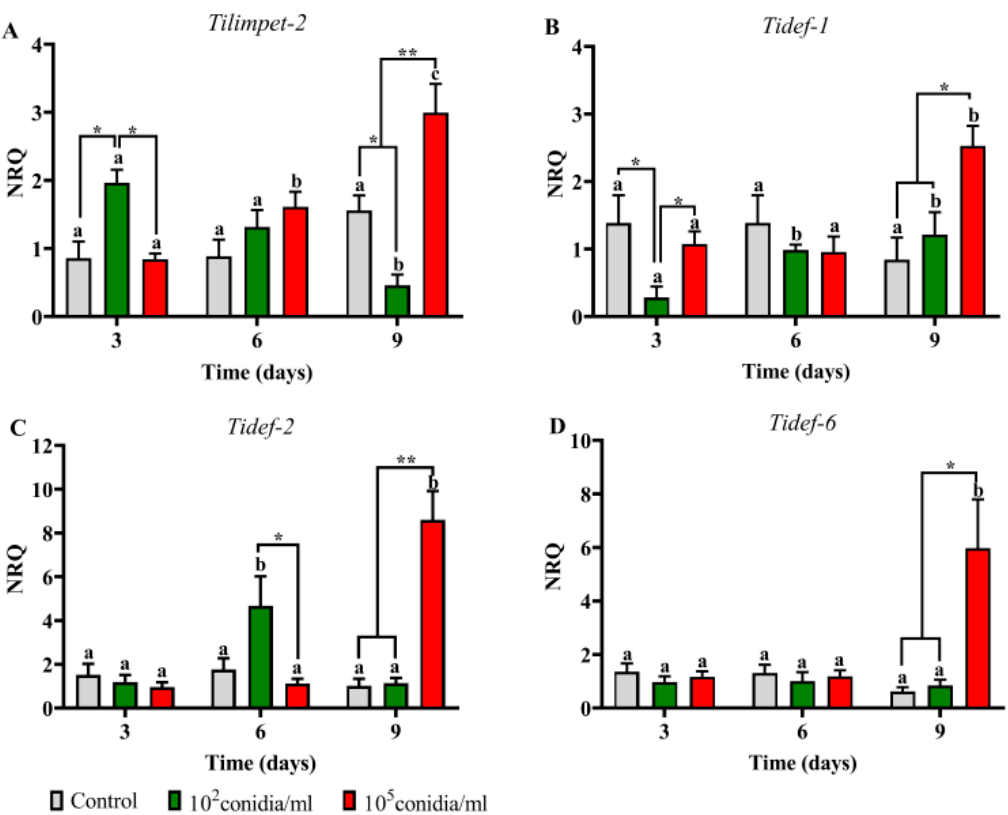
Figure 7. Expression pattern of limpet ( A ) and defensin ( B – D ) genes in Beauveria bassiana -infected pyrethroid-resistant nymphs of Triatoma infestans . Normalized relative quantities (NRQ) are shown at different time periods after insect immersion in conidial suspensions. Values are means of three replicates ± SEM. For each gene, different letters indicate significant differences for each treatment through time. Asterisks indicate significant differences in gene expression at each time point. * p < 0.05; ** p ˂ 0.005.